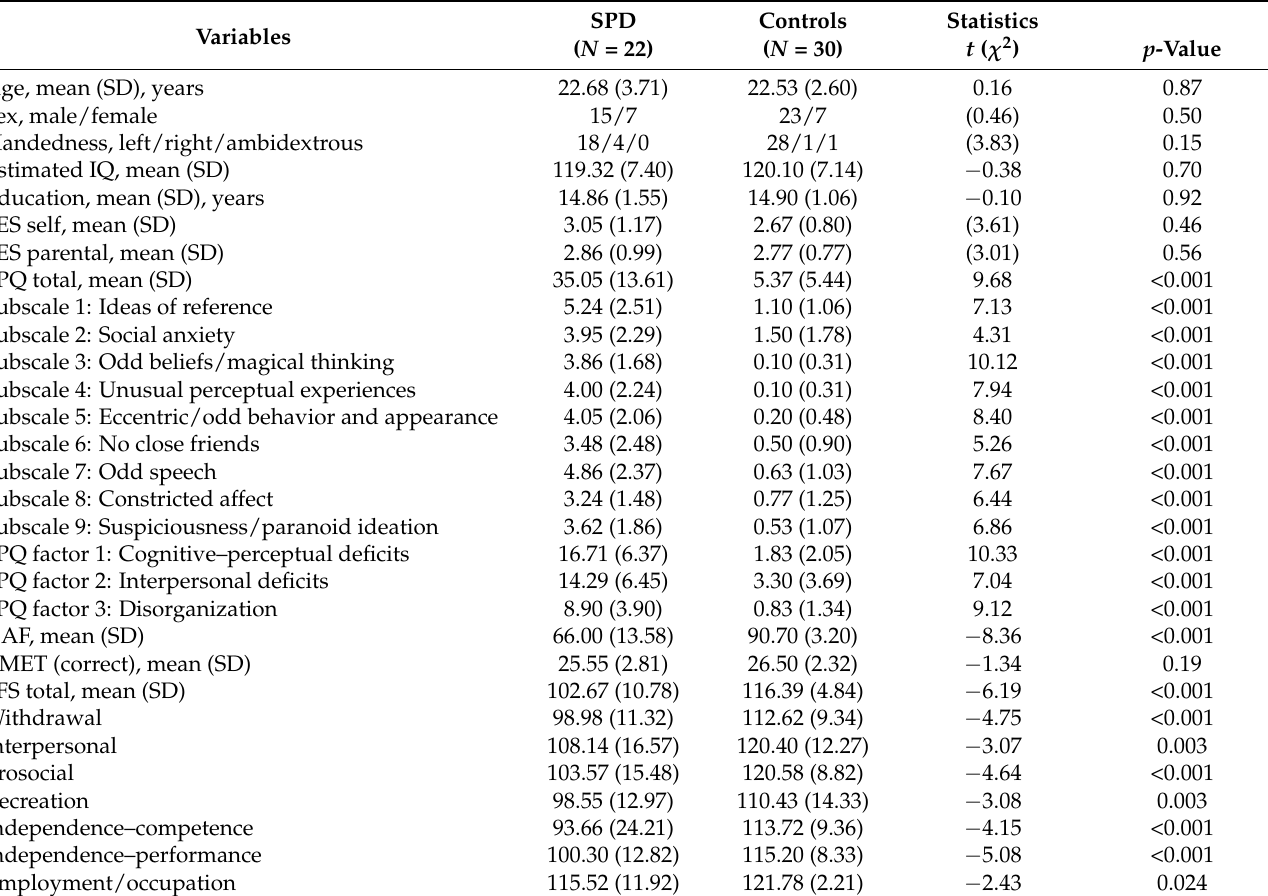
Table 1. Demographic, clinical, and psychological